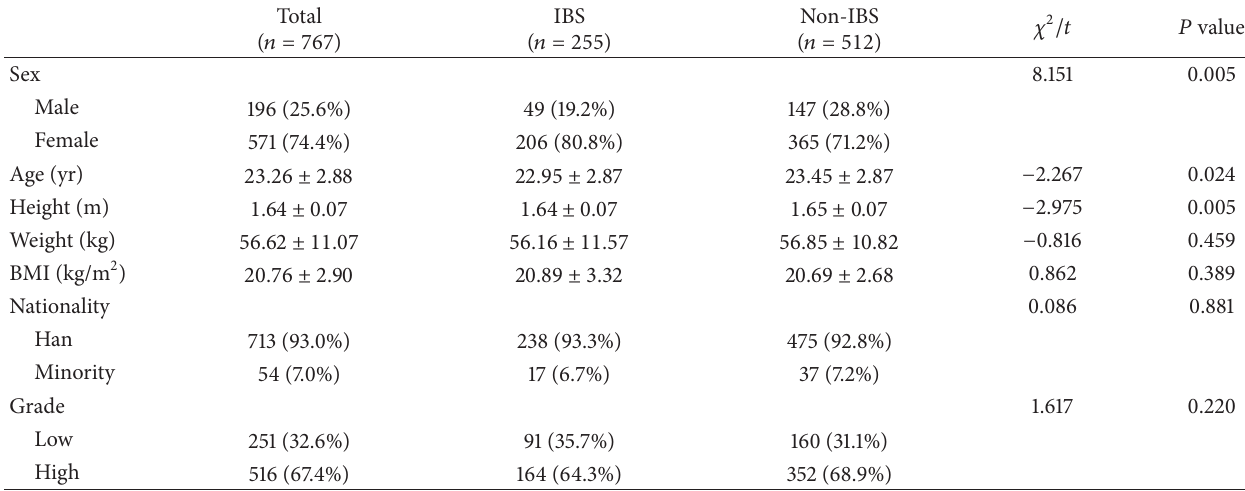
Table 1: Characteristics of medical students with or without IBS n